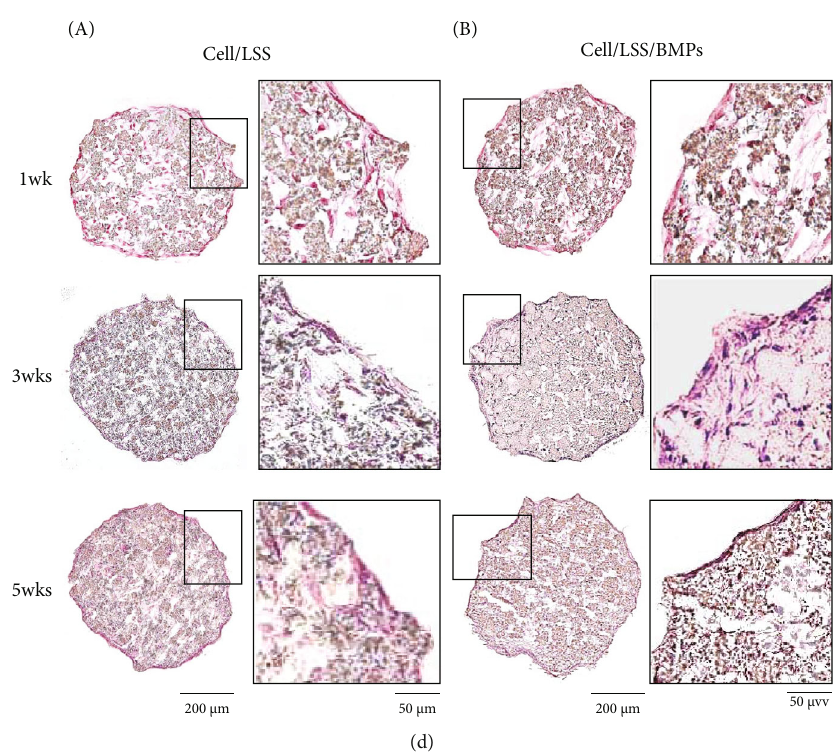
Figure 2: Formation of hDPSC spheroids containing the BMPs-loaded LSS microparticles. (a, b) Photographic and scanning electron microscopic image of hDPSC spheroids. (A) hDPSC spheroid without particles. (B) hDPSC spheroid with particles. (C) hDPSC spheroid with BMPs-loaded particles. (c) Cell proliferation of hDPSCs in spheroids containing microparticles after culturing for 1, 3, and 5 weeks. 0wk indicated the cell numbers added for spheroid formation. White bars, cell numbers in spheroids containing particles without BMPs; black bars, cell numbers in spheroids containing particles loaded BMPs. ∗ P < 0 : 05 ; ∗∗ P < 0 : 01 ; ∗∗∗ P < 0 : 001 ; NS: not signi fi cant. (d) H&E staining of para ffi n section of hDPSC-spheroids containing LSS particles. As well as covering on spheroid by cell layers, cells were detected inside of spheroid. (A) hDPSC spheroid with particles. (B) hDPSC spheroid with BMPs-loaded